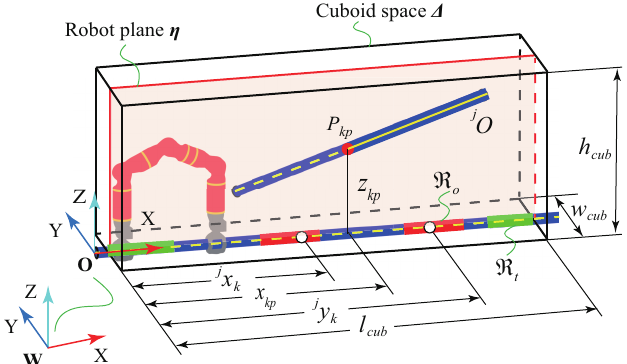
Figure 5. The definition of collision avoidance space and Key Point .